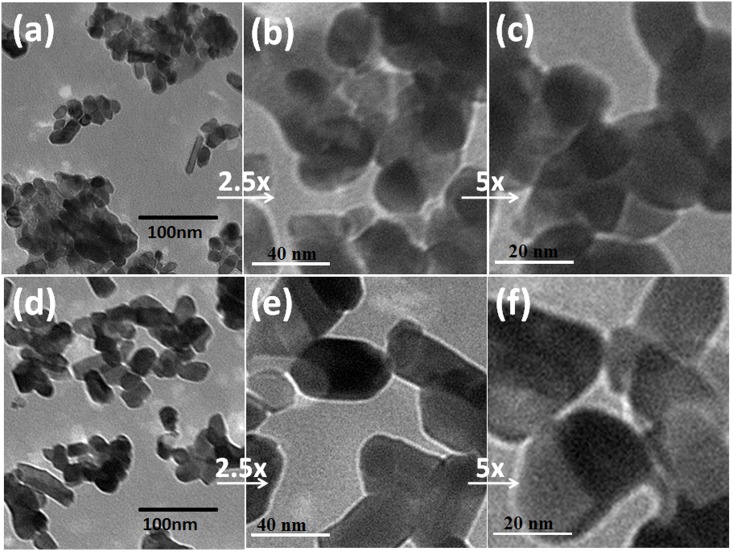
(a-c) transmission electron micrographs of ZnSnO3 (S1) and (d-f) of Zn2SnO4 (S5) samples.